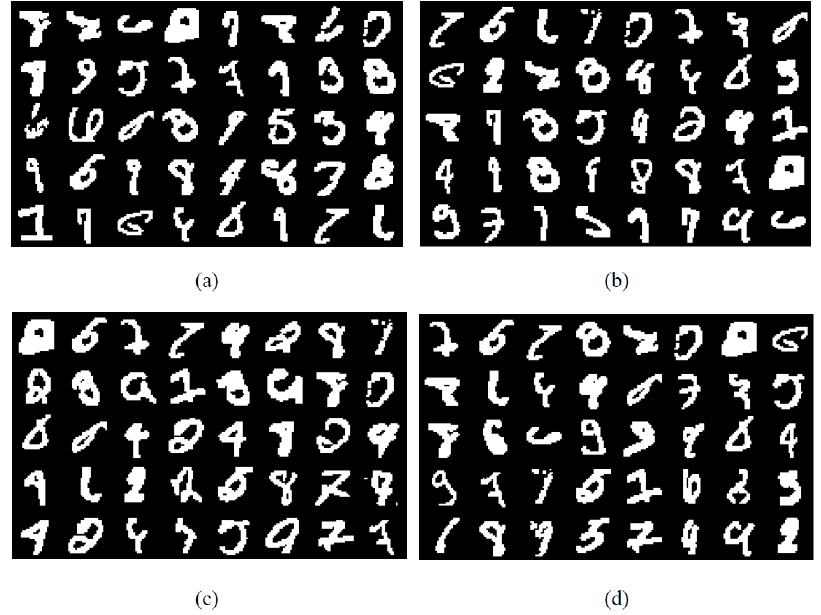
Figure 7. Images with the largest DSA values. ( a ) DSA0. ( b ) DSA1. ( c ) DSA2. ( d )